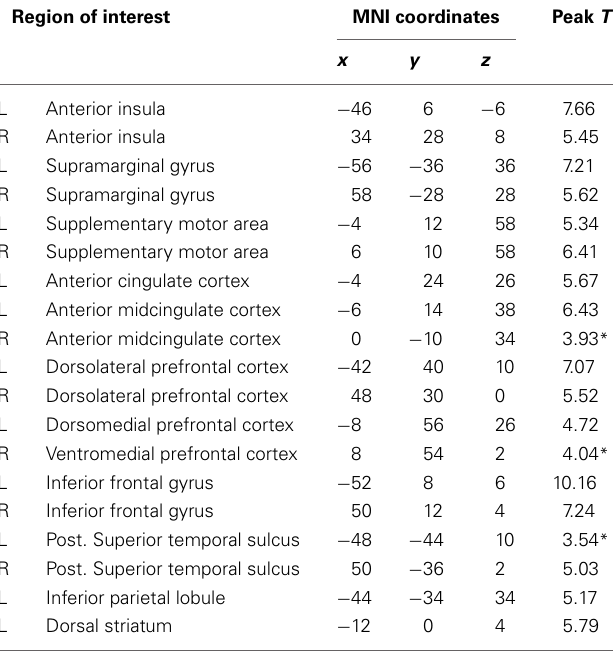
Table 2 | Imagine-other perspective. Region of interest MNI coordinates Peak